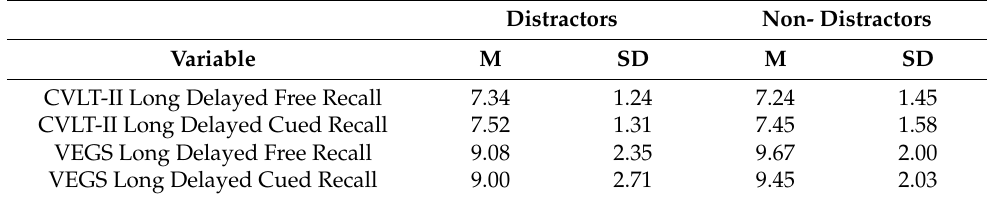
Table A2. Comparison of distractor performance on neuropsychological measures